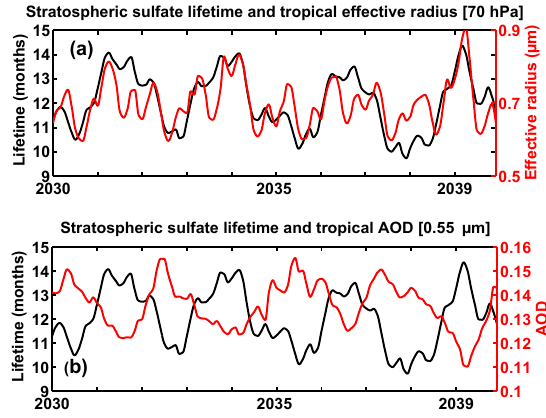
Figure 7. (a) Monthly means of geoengineering SO 4 lifetime (black; left scale; months) and tropical effective radius at 70hPa (red; right scale; µm; 20 ◦ S–20 ◦ N) for ULAQ-CCM (years 2030– 2039). (b) SO 4 lifetime, as in (a) and tropical aerosol optical depth at 0.55µm (20 ◦ S–20 ◦ N). Average values in the 2030–2039 decade are r eff = 0.70 ± 0.06µm, tropical AOD = 0.136 ± 0.010, global AOD = 0.079 ± 0.003. The calculated all-sky tropopause- adjusted radiative forcing from stratospheric geoengineering sulfate (G4-Base) is − 1.73 ± 0.07 (shortwave), + 0.53 ± 0.02 (longwave) and − 1.20 ± 0.05Wm − 2 (net). The E–W shear average anomaly of the net RF (radiative forcing) is calculated to be + 0.06Wm − 2 (i.e., when the lifetime is longer, there is an average 4% decrease in the long-term calculated net